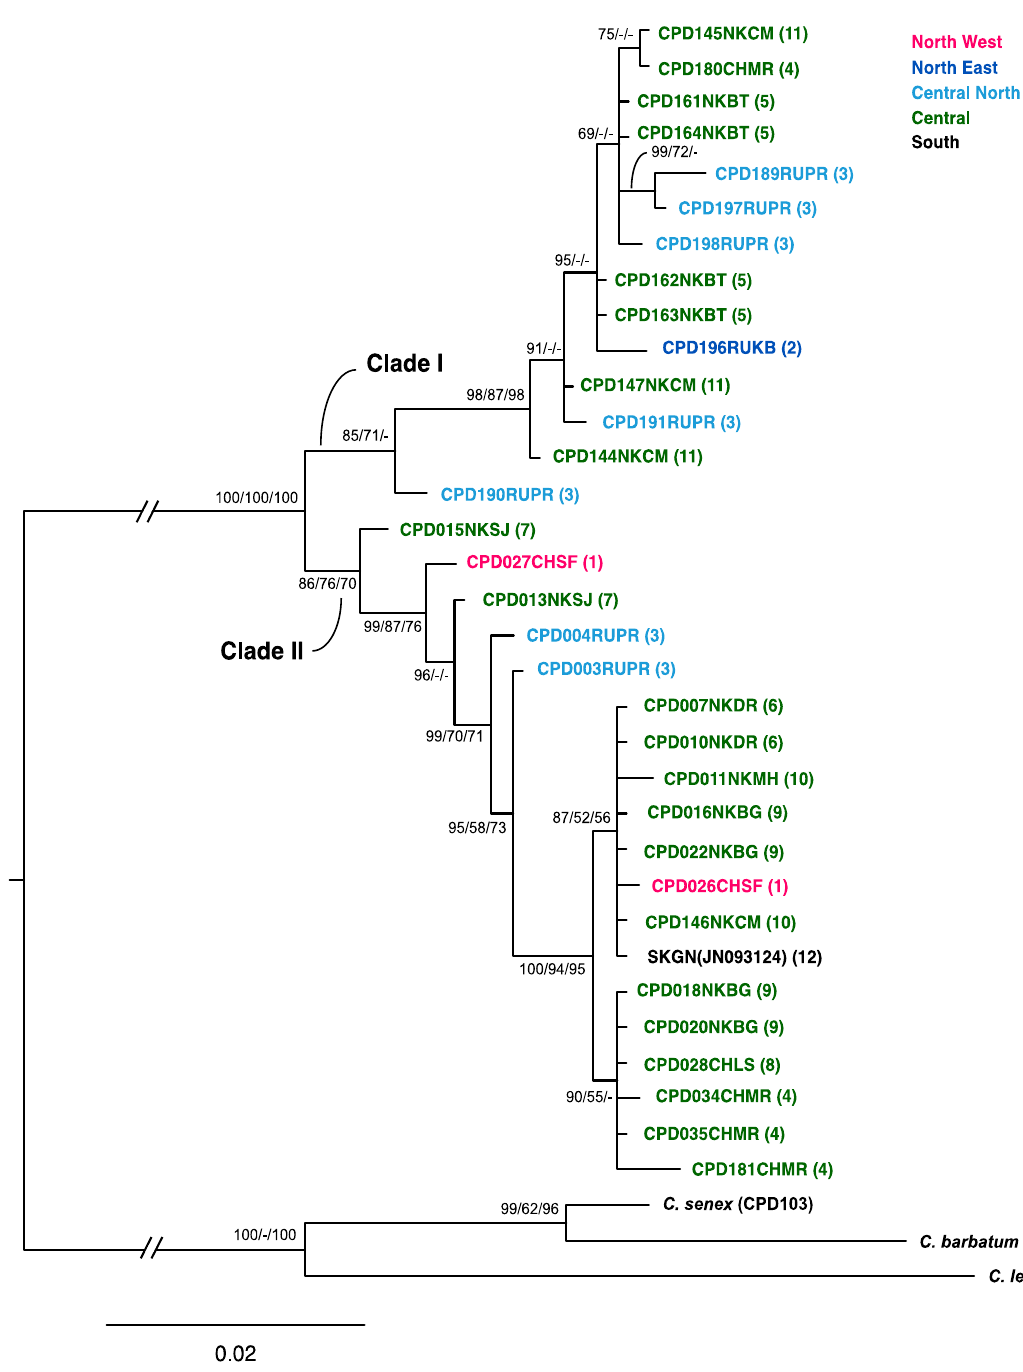
Figure 3. Phylogenetic tree of C. relictus using COI sequences and tree topology is shown based on Bayesian inference. Sampling site numbers are shown in the parentheses. The numbers above the nodes indicate Bayesian posterior probabilities (BI), maximum likelihood (ML), and neighbor-joining (NJ) bootstrap values, respectively. The nodes with values < 50% are shown as “-”.